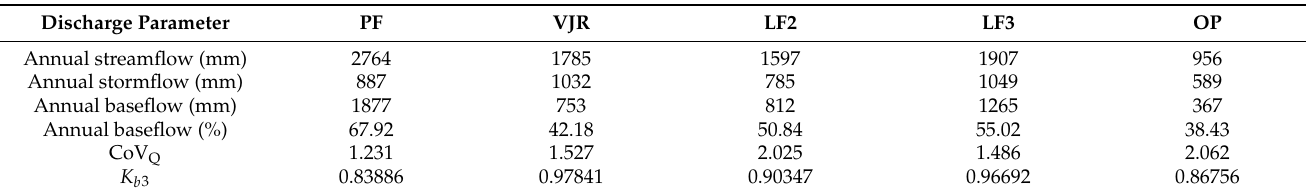
Table 5. Values of discharge parameters for the catchments of differing land-use. All parameters were derived from the full dataset (22 months) except for K b 3 which was derived from the recession dataset (37 recession events).